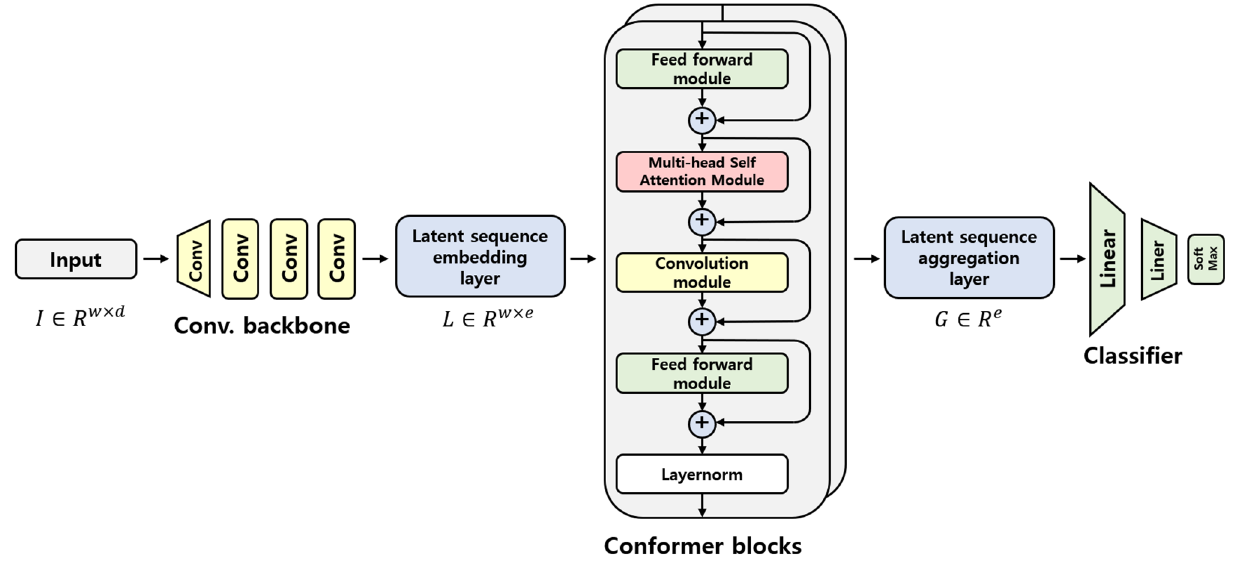
Figure 2. Proposed conformer-based HAR model.